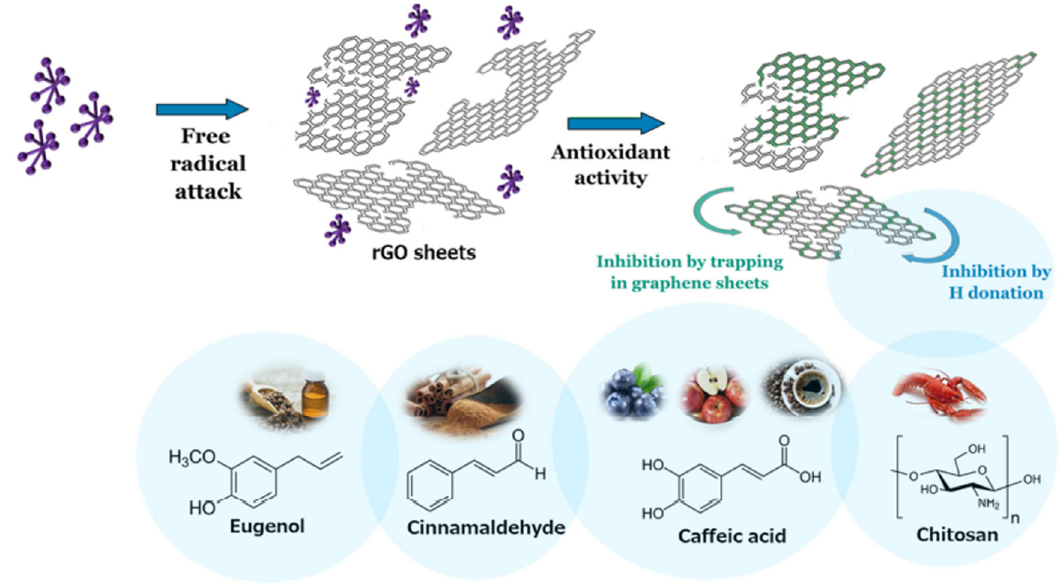
Figure 9: Improvement of the scavenger activity of reduced graphene oxide in the presence of free radicals when combined with natural bioactive compounds [ 86 ] .